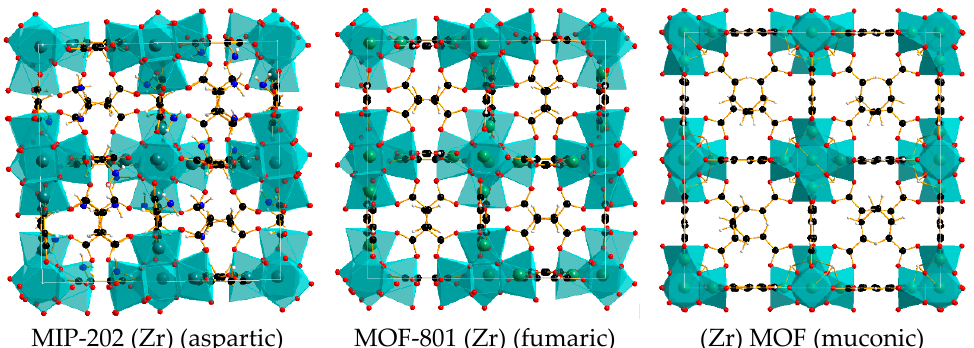
Figure 2. Structures of the three MOFs investigated (black: carbon, red: oxygen, green: Zr, blue: nitrogen, white: hydrogen).